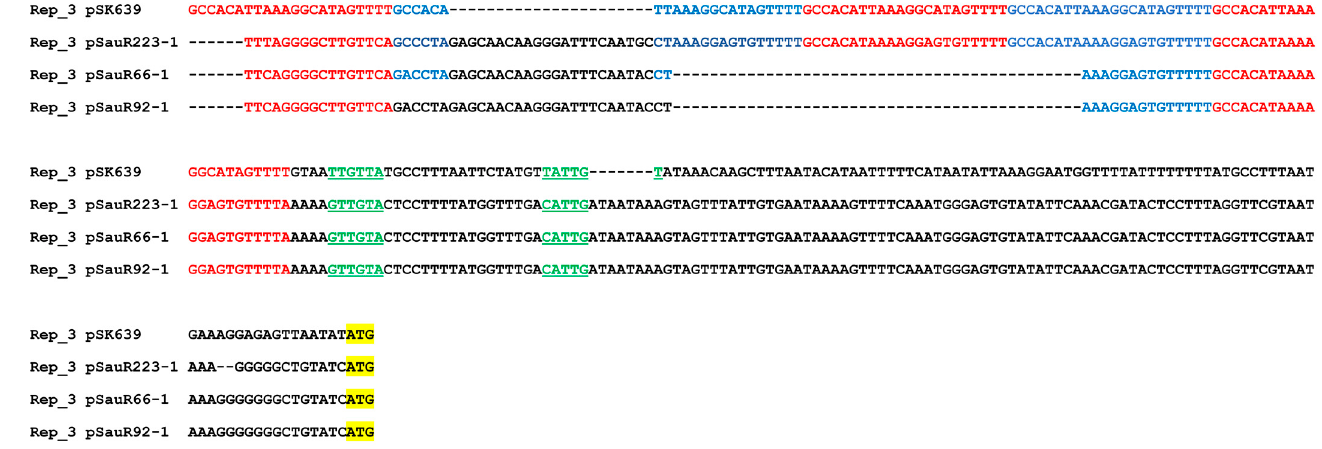
Figure 3. Multiple sequence alignment of the upstream regions of rep_3 of pSauR223-1, pSauR66-1, and pSauR92-1 (as representative) with the upstream region of rep_3 of pSK639 as reference (NC_005566.1; [59]). In pSK639, five direct repeats (indicated here in alternating red and blue fonts) are the Rep binding sites that precede the rep_3 gene. The predicted rep promoter (green and underlined) is found adjacent to these Rep binding sites. The ATG start codon of rep_3 replicase is highlighted in yellow. Note that in pSauR223-1, pSauR66-1, and pSauR92-1, some of the direct repeat sequences were interrupted or deleted.